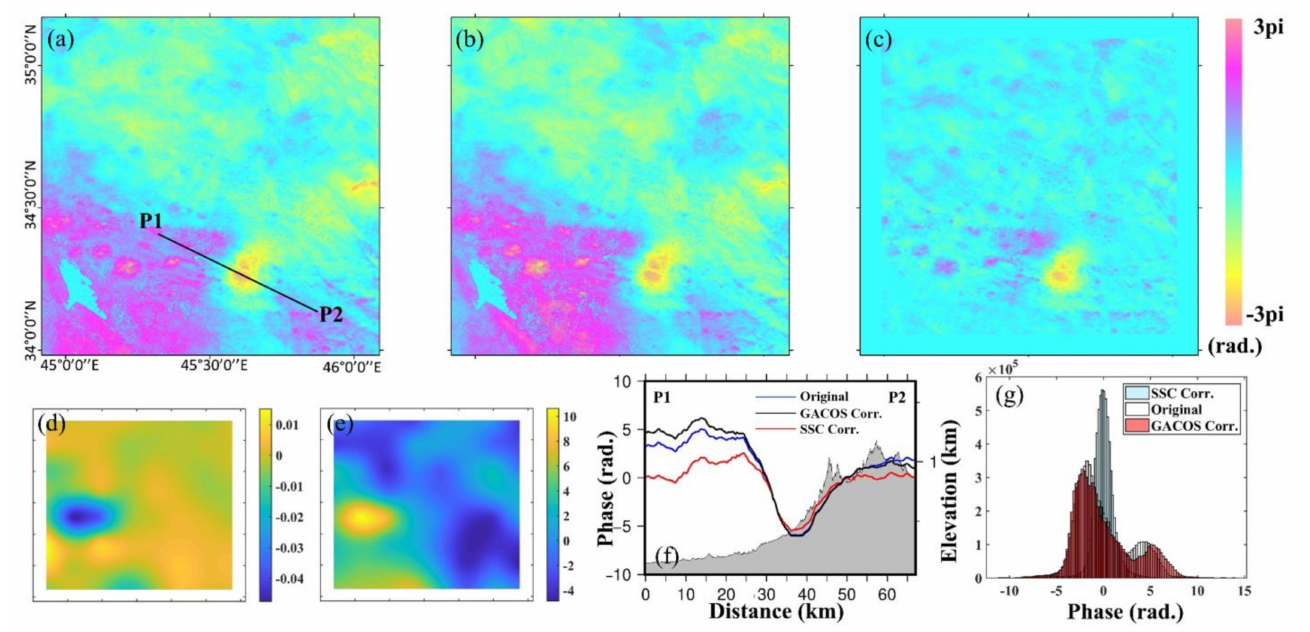
Figure 3. Examples of atmospheric correction: ( a – c ) are original, GACOS-corrected, and SSC- corrected interferograms of the Mw 6.5 Sarpol-e Zahab, Iran, earthquake; ( d ) is the scale factor map; ( e ) is the offset factor map; ( f ) shows the phase changes along cross section P1–P2 in ( a ); ( g ) is the histogram of ( a – c ) after masking the main coseismic zone.